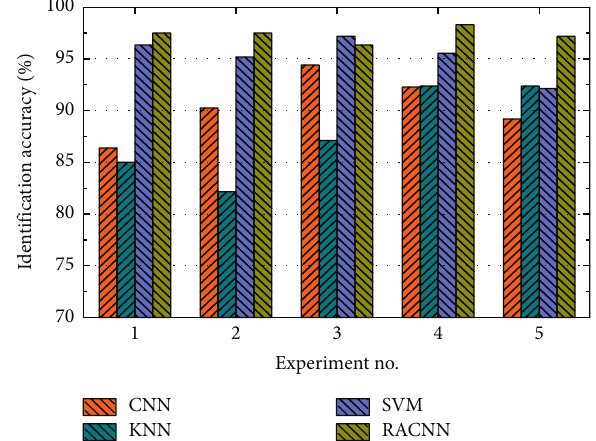
Figure 8: Results of different